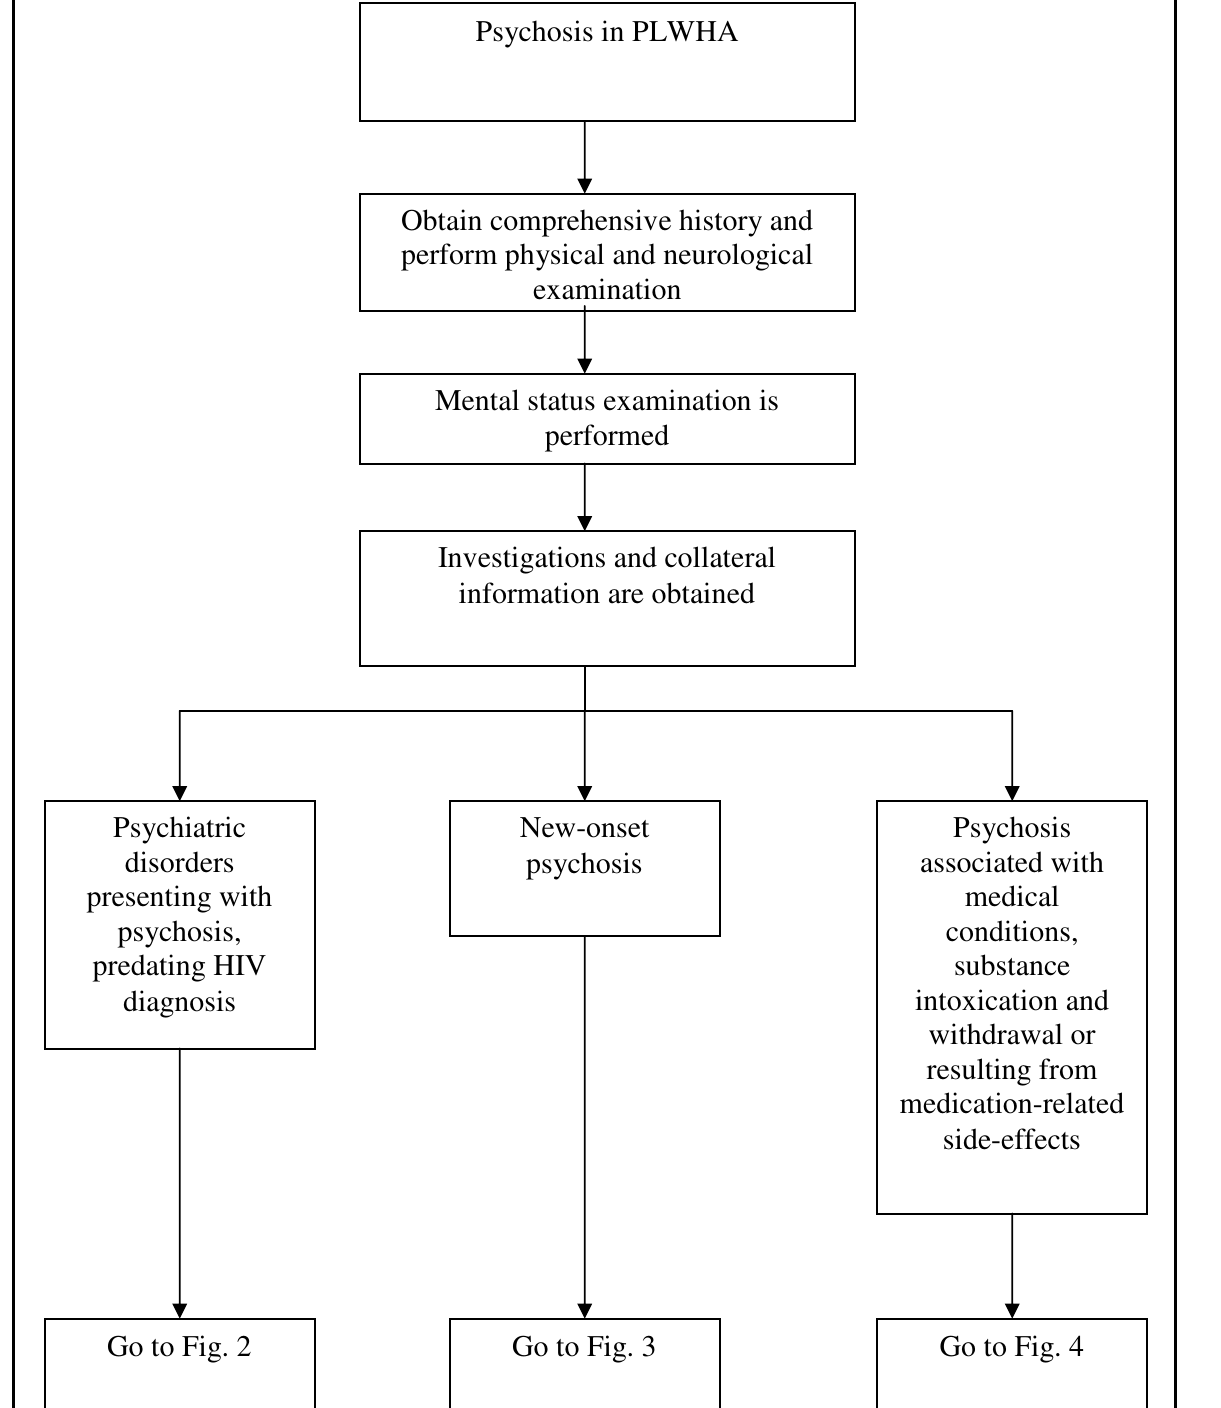
Fig. 1. Approach to the assessment of psychosis in